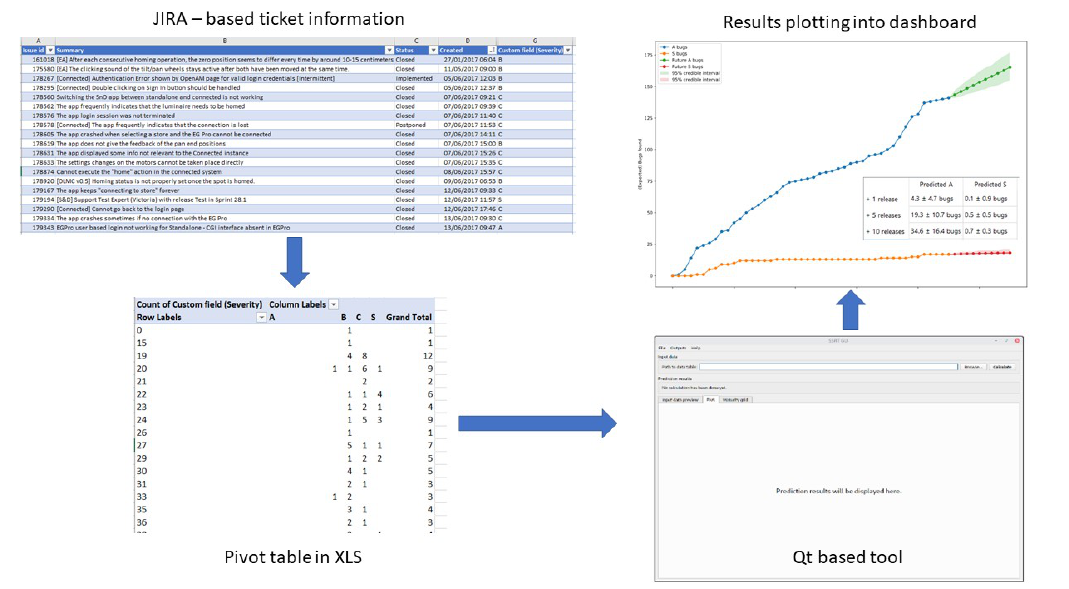
Figure 6. Flowchart for automatic generation of software reliability predictions. Details are explained in the